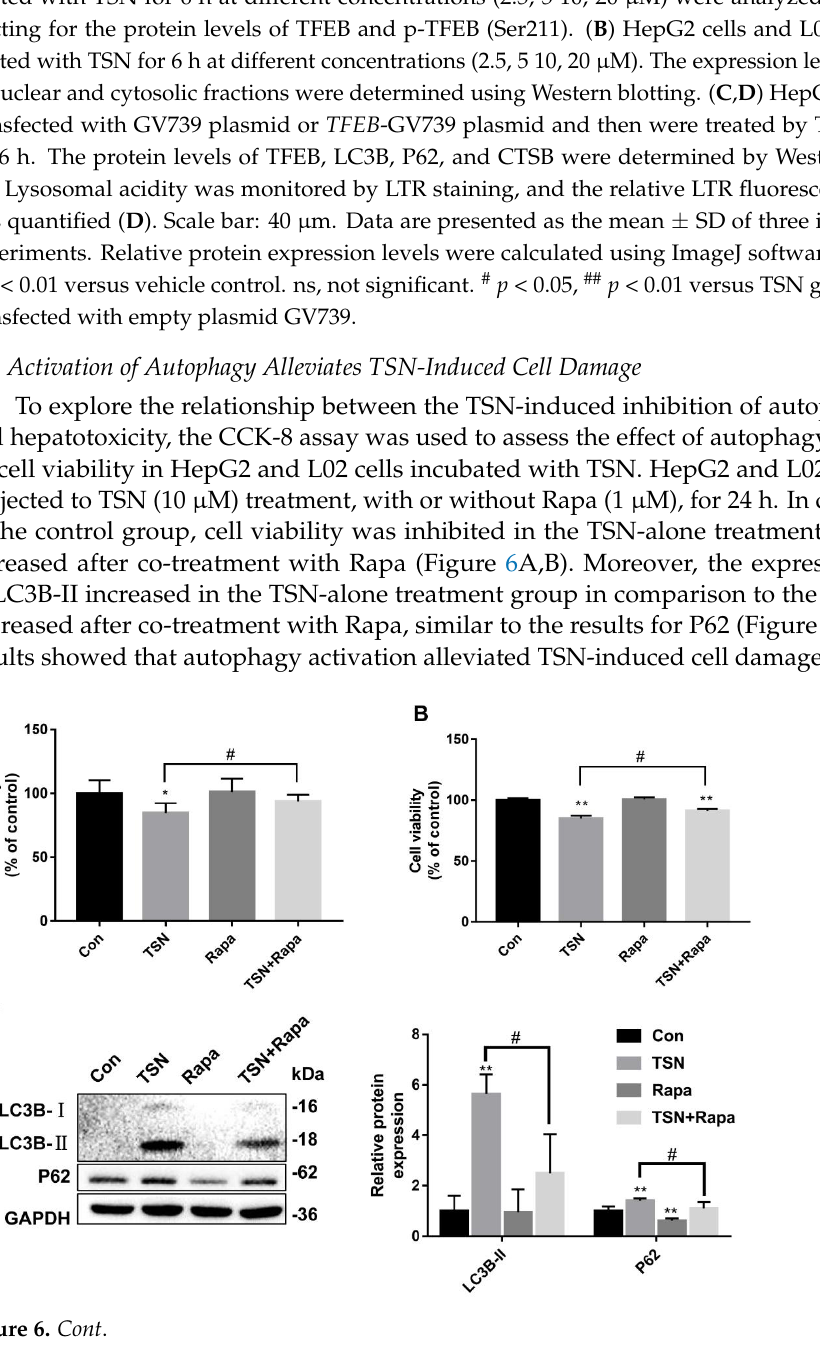
Figure 6. Activation of autophagy alleviated TSN-induced cell damage. HepG2 and L02 cells were treated by TSN (10 μM) with or without Rapa (1 μM) for 24 h. ( A ) (HepG2) and ( B ) (L02) cell viability was determined using a CCK-8 assay kit. ( C ) (HepG2) and ( D ) (L02) protein levels for LC3B and P62 were analyzed by Western blotting, and the ratios of LC3B- Ⅱ /GAPDH and P62/GAPDH were calculated using ImageJ software. Data are presented as the mean ± SD of three independent experiments. * p < 0.05, ** p < 0.01 versus control; # p < 0.05, ## p < 0.01 versus TSN group. 2.7. TSN Induces Liver Injury in Balb/c Mice The hepatotoxicity of TSN in vivo was investigated. Balb/c mice were intraperitoneally administered TSN at different doses (5, 10, 20 mg/kg) or by vehicle for 24 h. Compared with the vehicle group, the relative liver weight (liver weight to body weight ratio) in the TSN-administration groups increased in a dose-dependent manner (Figure 7A). Serum ALT, AST, and LDH levels were elevated in TSN-administration mice (Figure 7B – D). The results of a liver histological evaluation further confirmed the liver injury caused by TSN. In the vehicle group, the structure of hepatic sinusoid was clear, the structure of hepatocytes was intact, and the arrangement of hepatocytes was ordered. However, especially in the high-dose TSN group, hepatocyte necrosis, nuclear pyknosis,